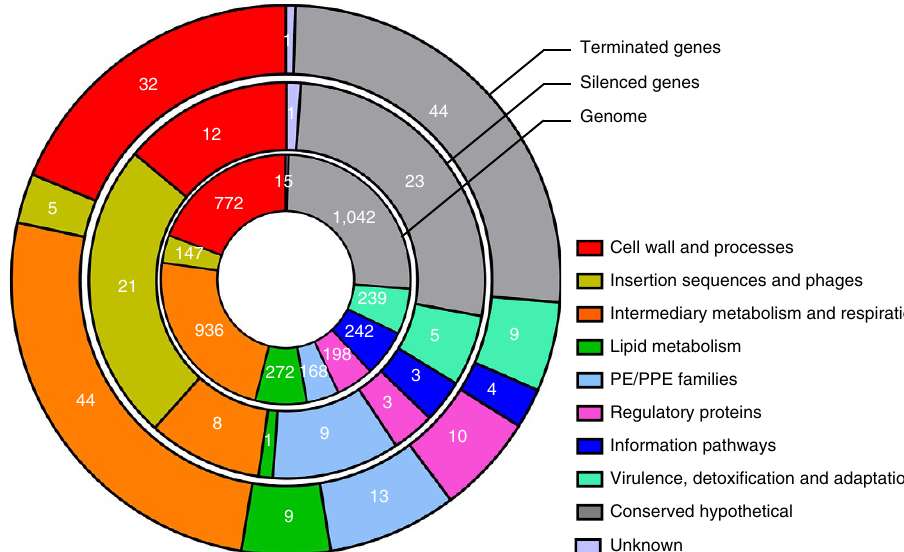
Figure 3 | Genes silenced or terminated by Rho in M. tuberculosis . Classification of M. tuberculosis genes according to their function and impact of Rho. The genes silenced or terminated by Rho are classified in families based on their product function (Tuberculist). The percentage of genes in each category is represented as sections of the circle. The repartition of all genes of the M. tuberculosis genome in the same functional categories has been added for comparison. The number in white represents the absolute number of genes found for each category.